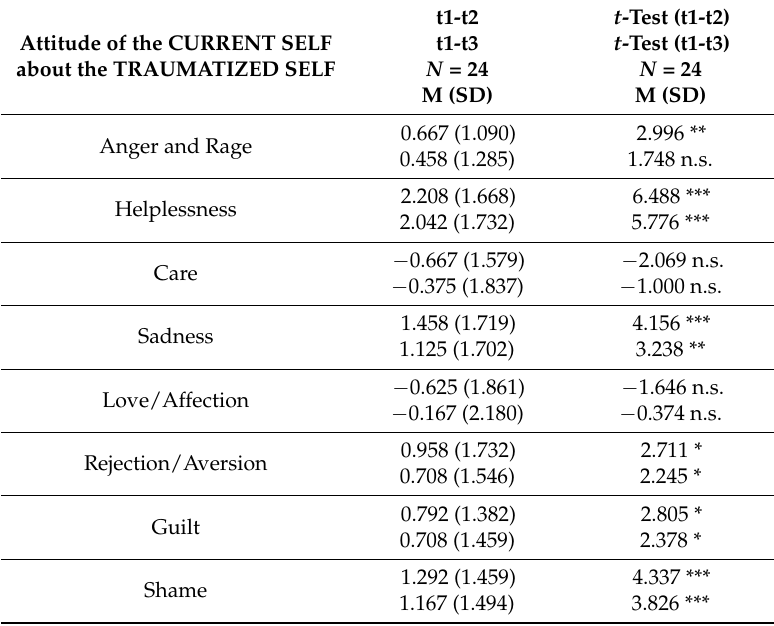
Table 2. Change in emotions between CURRENT SELF and TRAUMATIZED SELF (t1-t2 and